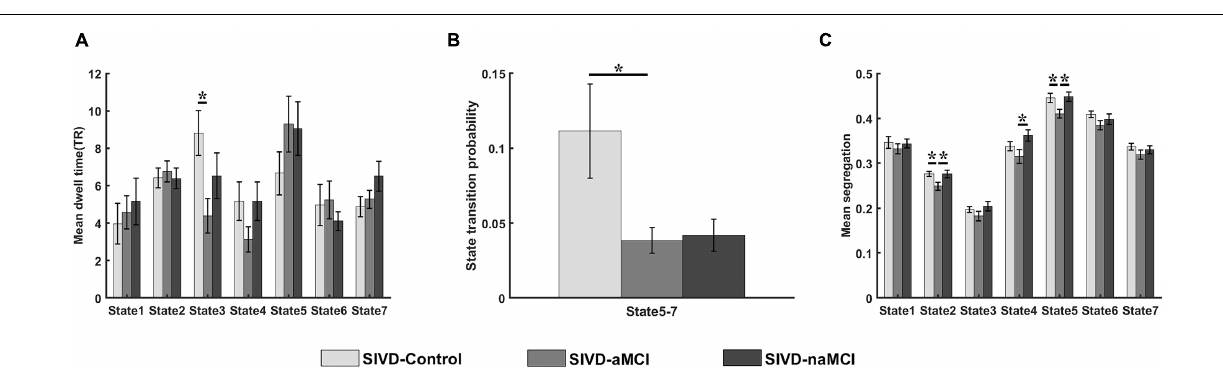
matrixes of any two groups to identify the intergroup